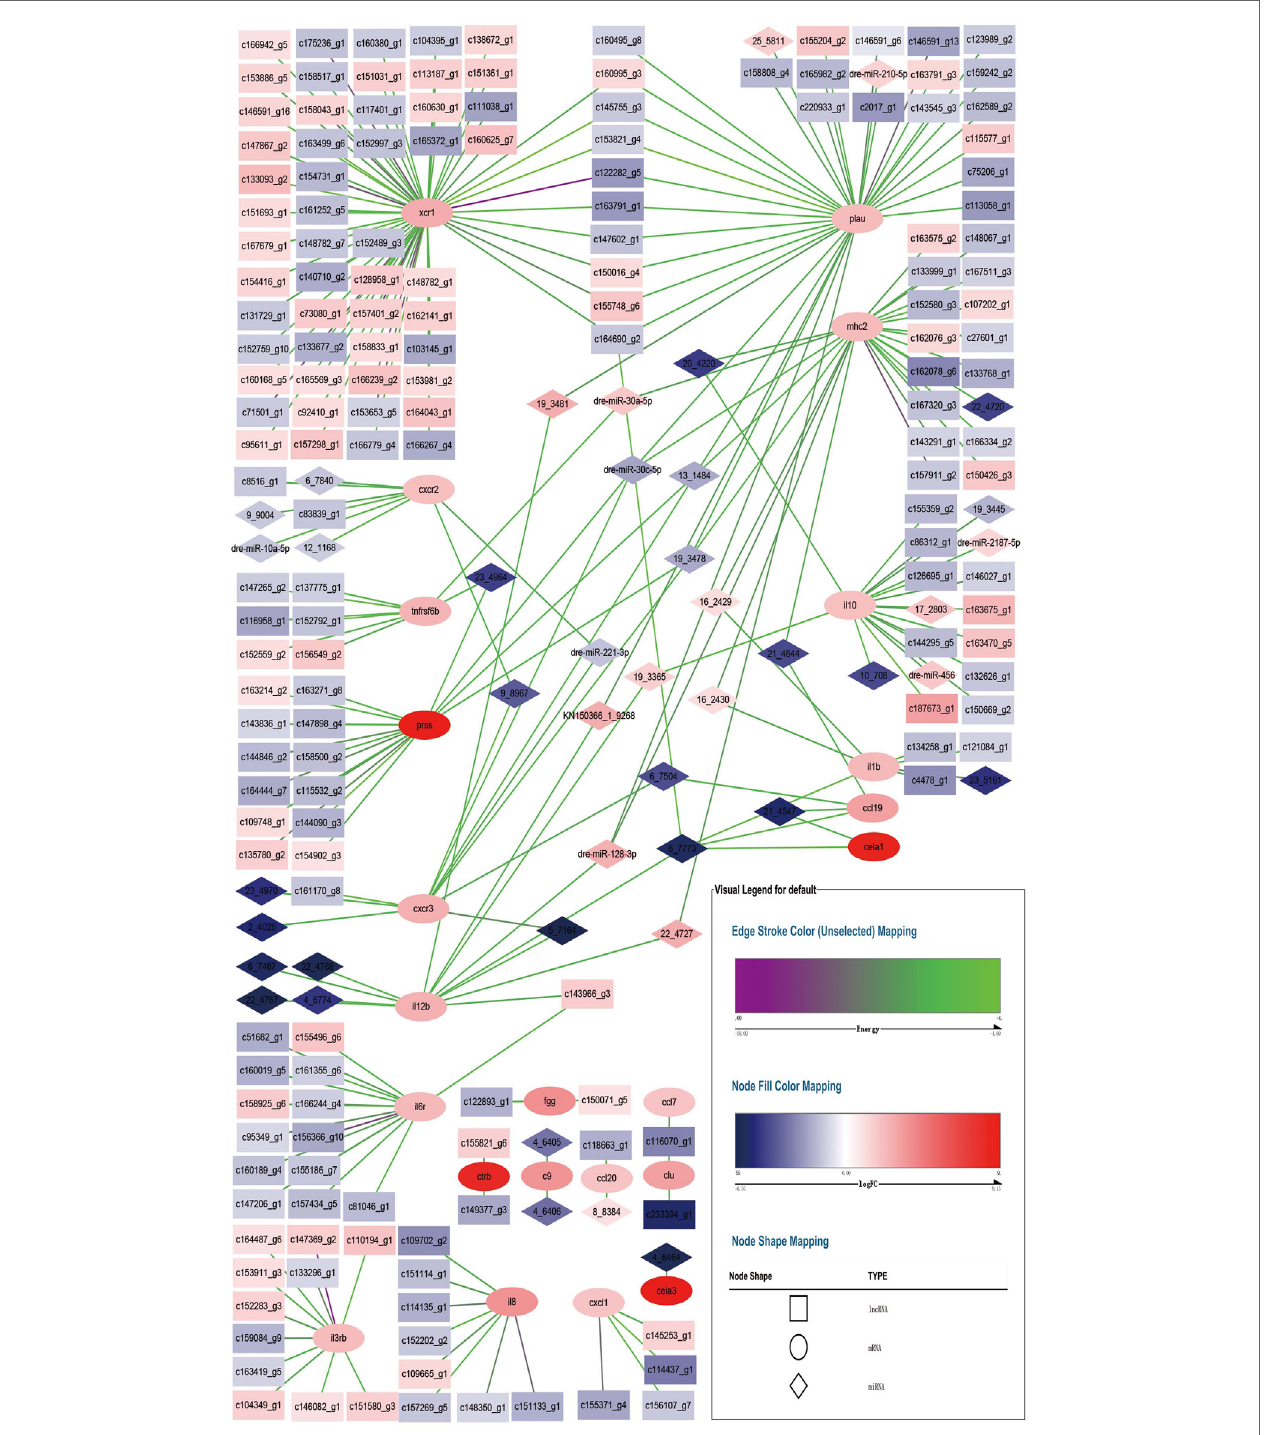
FigUre 5 | Network for differentially expressed miRNA–mRNA–lncRNA relationship. Square nodes represent differentially expressed lncRNAs, circle nodes represent differentially expressed mRNAs, and rhombus nodes represent differentially expressed miRNAs. Red color of nodes represent up-regulate and blue color of nodes represent down-regulate. The darker the color, the greater the change. Edges color range from purple to green represent interact energy from low to high. The smaller the purple energy, the closer the